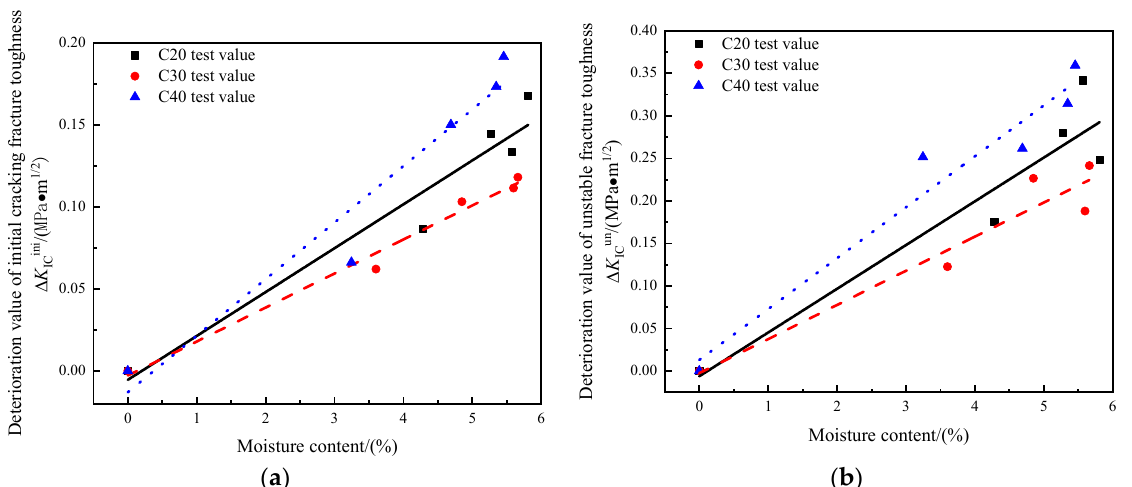
Figure 5. Variation curve of deterioration value of initial cracking fracture toughness and unstable fracture toughness of concrete under different moisture content. ( a ) Deterioration value of initial cracking fracture toughness ( b ) Deterioration value of unstable fracture toughness. The horizontal load–crack opening displacement curves of C20, C30, and C40 concrete under different moisture content conditions are shown in Figure 6a–c. According to Figure 6, the variation rule of P H –CMOD curves of C20, C30, and C40 concrete under different moisture content was essentially the same, and the critical crack mouth opening displacement gradually decreased with the increase of moisture content. For example, C20 concrete CMOD C in the dry state was 1.56 times greater than in the saturated state. The fracture deformation under different moisture content can be divided into three stages.